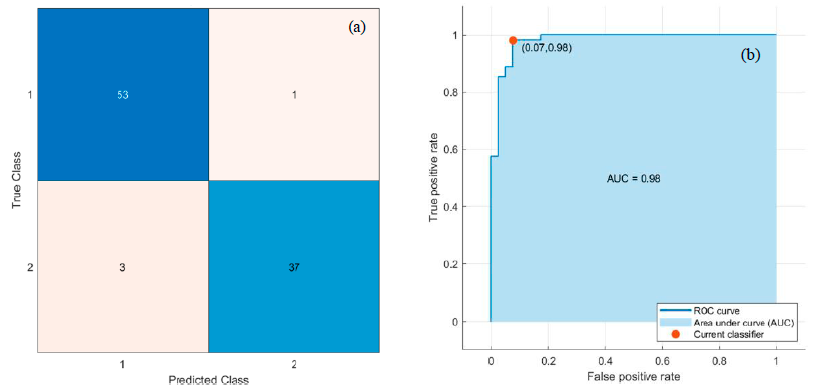
Figure 11. Best results with SVM Classifier: ( a ) Confusion matrix, and ( b ) ROC curve.